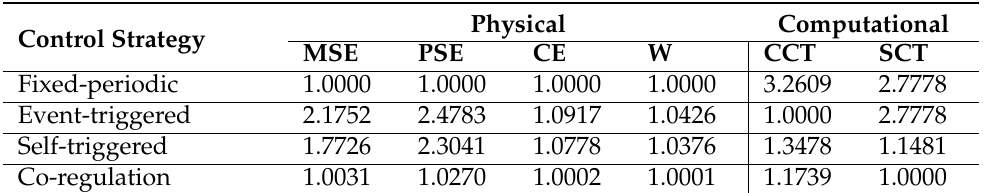
Table 3. Evaluation metrics of different sampling and control strategies (the lower value denotes better performance).